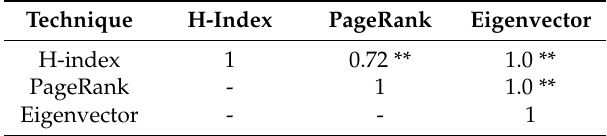
Table 8. Kendall correlation between PageRank, Eigenvector and the h-index.